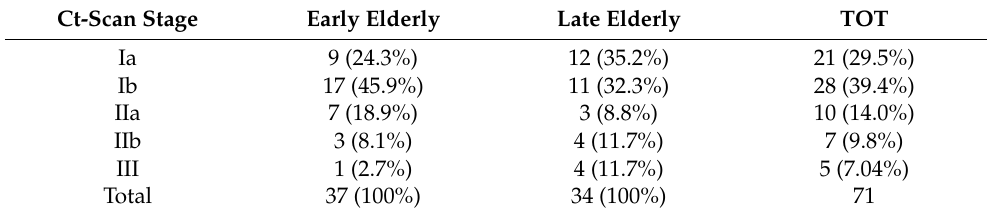
Table 2. Abdominal CT-scan stage according to 2015 WSES driven classification of